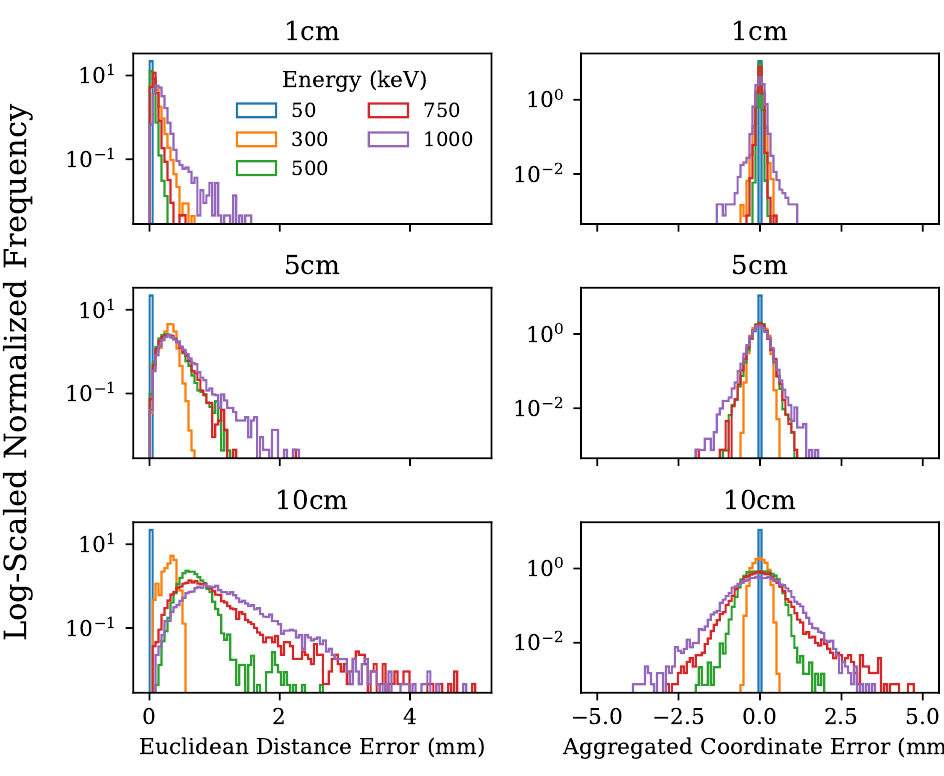
Figure 2. Accuracy of the head model for the 200 µ m pixel pitch case. Left column: Euclidean distance between the true and predicted head locations. Right column: Difference between the true and predicted head coordinate aggregated across all coordinate